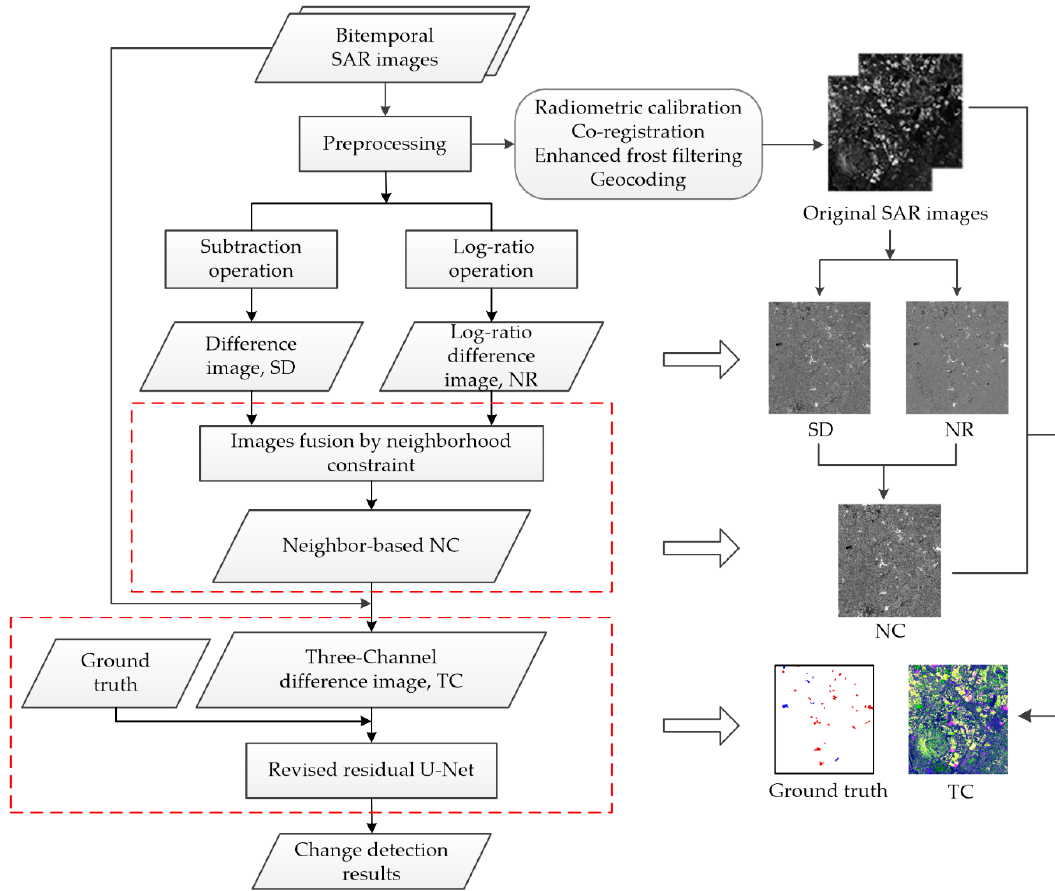
Figure 1. The flowchart of the proposed urban building change detection method. The areas enclosed by the red-dashed lines are the innovations of this paper.